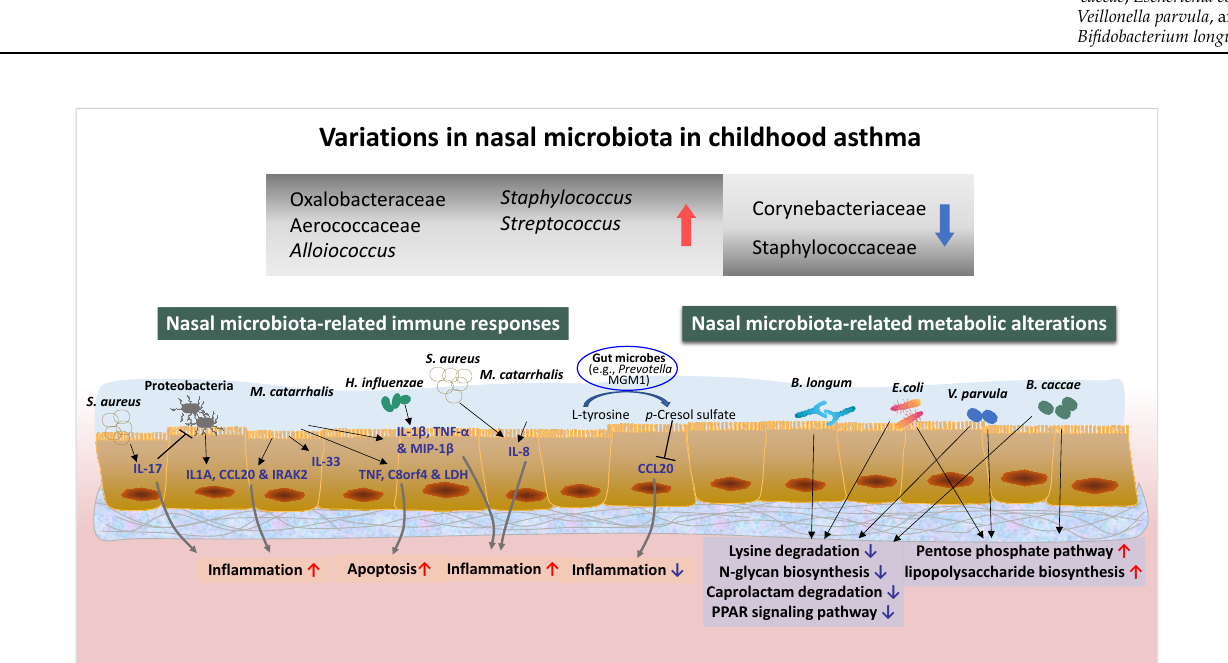
Figure 1. Variations in nasal microbiota and species-specific responses of the airway mucosa and metabolic pathways induced by microbiota colonisation. Changes in representative nasal microbiota, such as higher abundances of Oxalobacteraceae, Aerococcaceae, and Alloiococcus ( ↑ ) and lower abundances of Corynebacteriaceae and Staphylococcaceae ( ↓ ) [28], are involved in the development of early-onset wheezing in infants. Higher abundances of Staphylococcus and Streptococcus ( ↑ ) are more prevalent in asthmatic children than in healthy controls [55]. Opportunistic pathogens that colonise the mucosal layer are associated with host inflammatory immune responses (IL-1 β , TNF- α , MIP-1 β , IL-17, CCL20, IL1A, IRAK2, IL-8, IL-33), apoptosis signals (TNF and C8orf4), and epithelial damage (LDH) [56,59,60,62]. Host IL-17 signalling can significantly restructure the nasal microbiome and successful resistance to pathogenic Proteobacteria colonisation [64]. p -Cresol sulphate, a metabolite of L-tyrosine used by gut microbiota, can protect the host against allergic airway inflammation by reducing CCL20 [102]. The different expression levels of functional genes from specific microbiota ( B. longum , E. coli , V. parvula , and B. caccae ) between asthmatic and non-asthmatic children significantly influence metabolic pathways